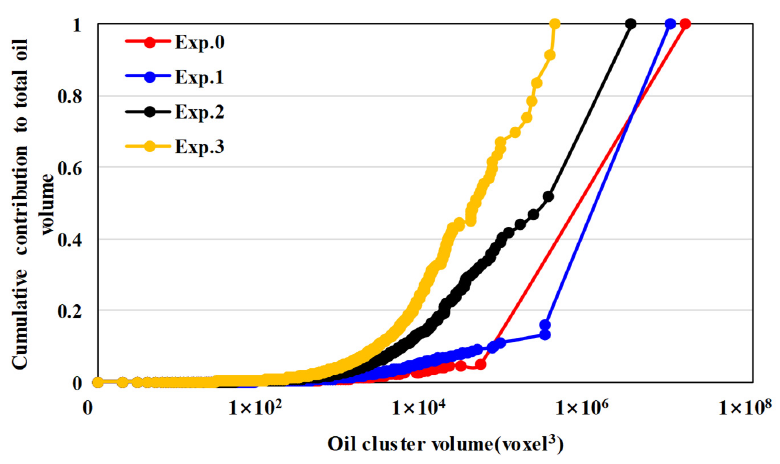
Figure 11. Cumulative contribution of various oil clusters to the overall oil volume in different